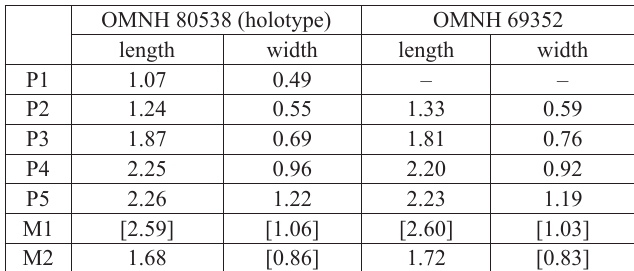
Table 1. Measurements (in mm) of crown lengths (mesiodistal) and transverse widths (through the widest point of the paracone base) of the morganucodontan mammaliaform Cifellilestes ciscoensis gen. et sp. nov., from the Upper Jurassic Morrison Formation of Utah, USA. Brackets indicate truncation due to wear. OMNH 80538 (holotype)